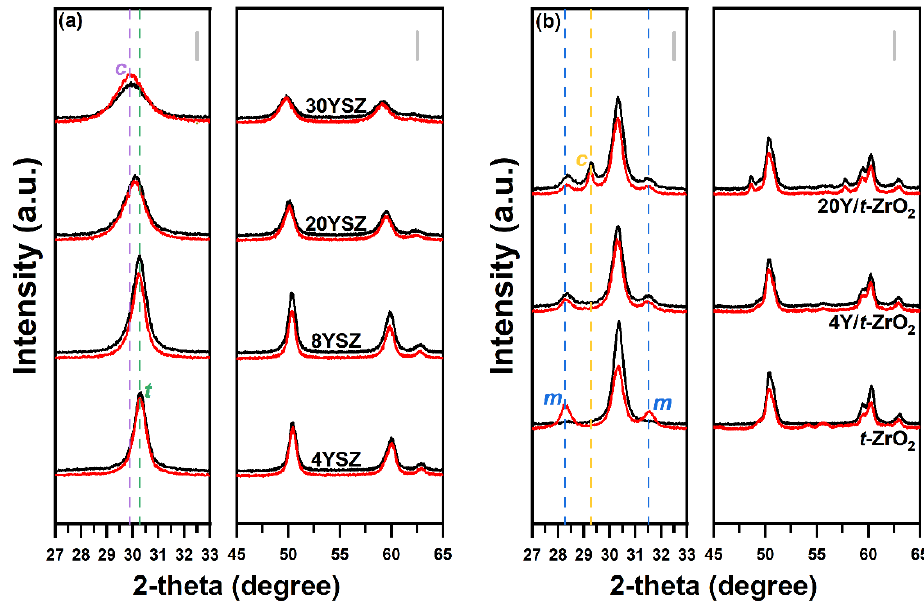
Figure 2. XRD patterns of the fresh (black lines) and spent (red lines) catalysts. ( a ) x YSZ ( x = 4, 8, 20, and 30). ( b ) x Y/ t -ZrO 2 ( x = 4 and 20) and bare t -ZrO 2 . The dot lines marked in purple, green, blue, and yellow represent the reflections of c -ZrO 2 , t -ZrO 2 , m -ZrO 2 , and c -Y 2 O 3 , respectively.